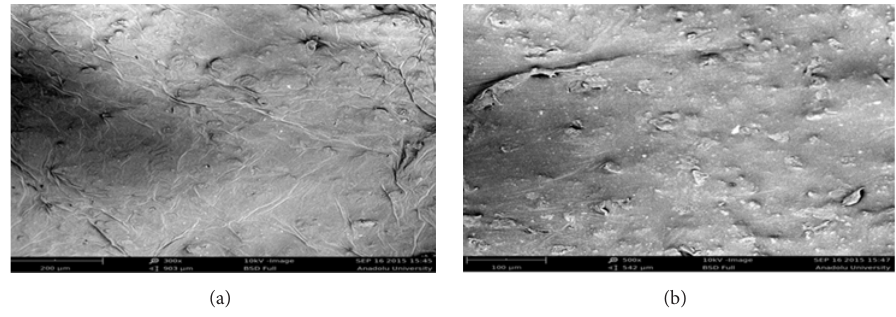
Figure 5: SEM images of uncured PK-BTM30CW70: (a) 300x; (b)